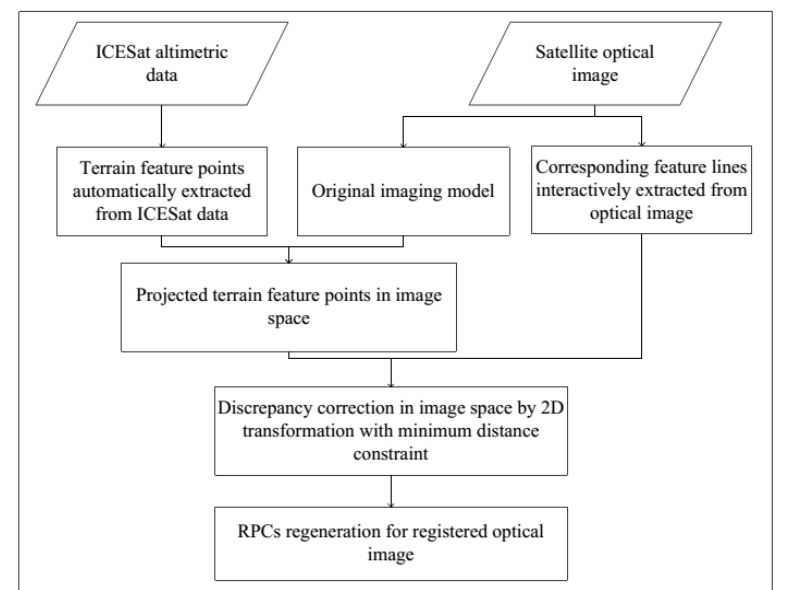
Figure 1. Framework of the methodology.